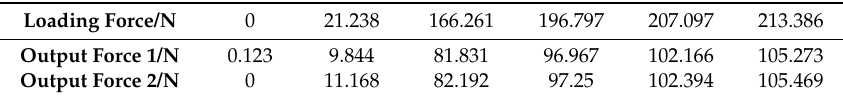
Table 1. Experiment 1 (the weight is 0 kg).